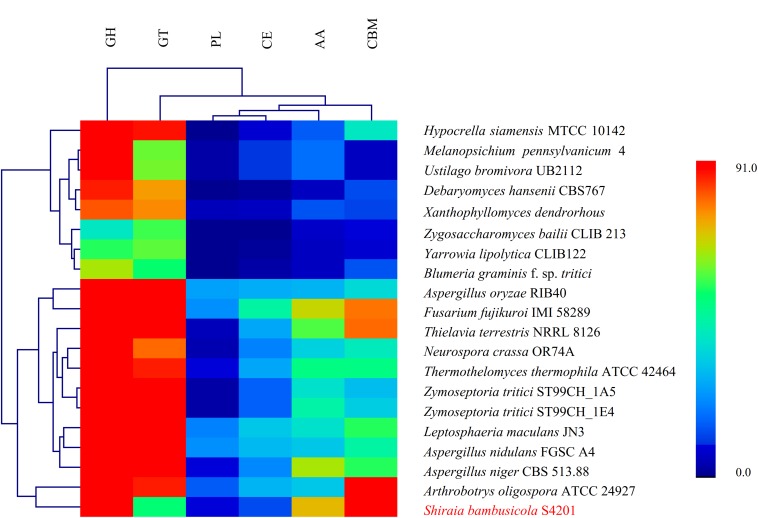
Hierarchical clustering of CAZyme in the genomes of Shiraia bambusicola and 19 other fungal species. The enzyme families are classified as follows: GH, glycoside hydrolases; GT, glycosyl transferases; PL, polysaccharide lyases; CE, carbohydrate esterases; AA, auxiliary activities; and CBM, carbohydrate-binding modules. The family numbers are based on the carbohydrate-active enzyme database. A color scale indicates the numbers of the different enzymes in each genome, from lowest (blue) to highest (red).